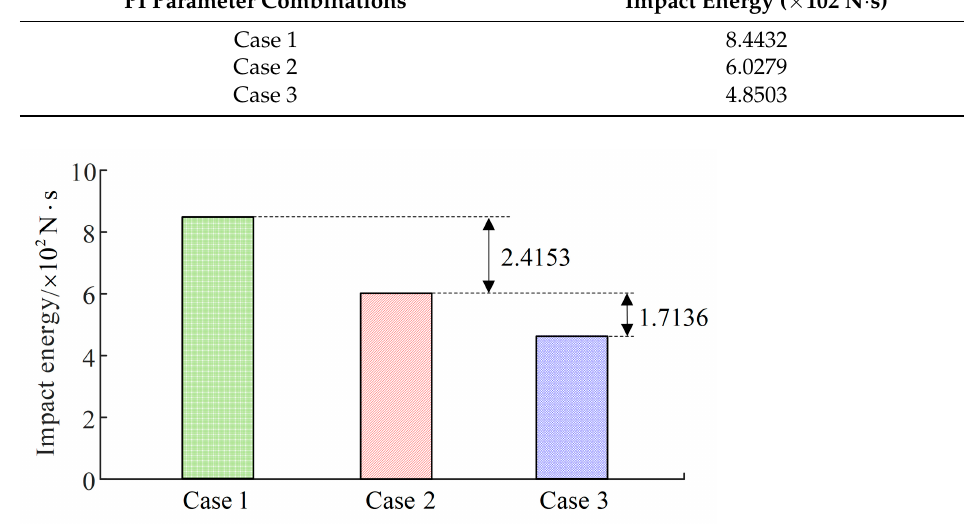
Figure 27. The impact energy of the transmission system with different PI parameters.